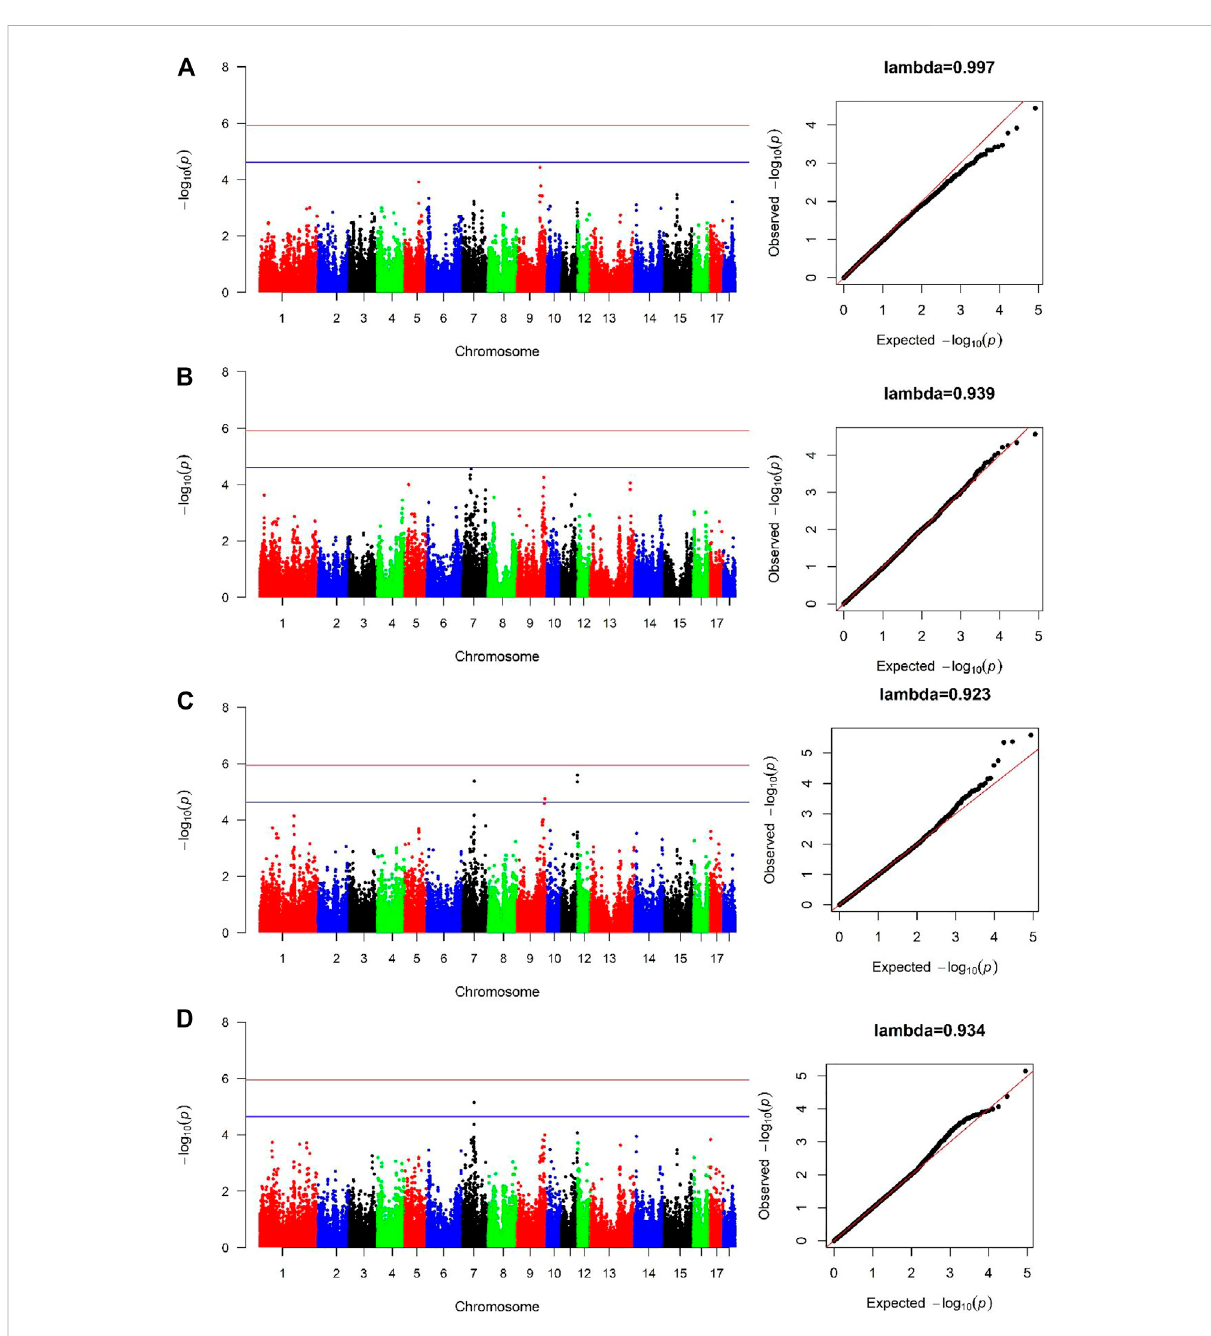
FIGURE 2 Manhattan and Quantile-Quantile (QQ) plotsof genome-wide association analysis for AGE100 trait. (A) is Canadian line. (B) is Frenchline. (C) is combined-population. (D) is cross-population GWAS analysis. The x-axis denotes autosomes. The y-axis indicates -log 10 ( p